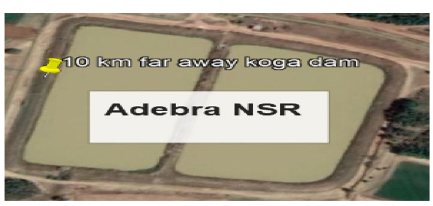
Fig. 2 Location of Adebra NSR area on Google Earth taken